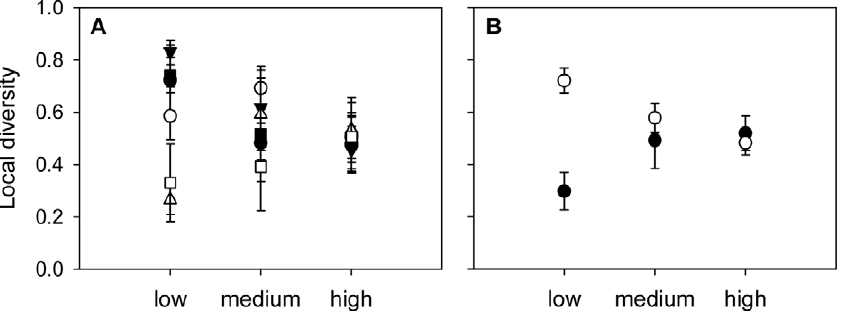
Figure 5. Effect of initial species combination on final local diversity. Values were averaged (A) over communities with the same initial species combination (means 6 SE, n=3) and (B) over communities with and without initial presence of Onychodromopsis (means 6 SE, n with =12, n without =6), respectively. Symbols depict (A) the six initial species combinations (SO: closed circles, SOF: open circles, SOFPU: closed triangles, U: open triangles, SOFP: closed squares, FP: open squares; species abbreviations as in Fig. 1) and (B) communities with initial presence of Onychodromopsis (open circles) and without initial presence of Onychodromopsis (closed circles).